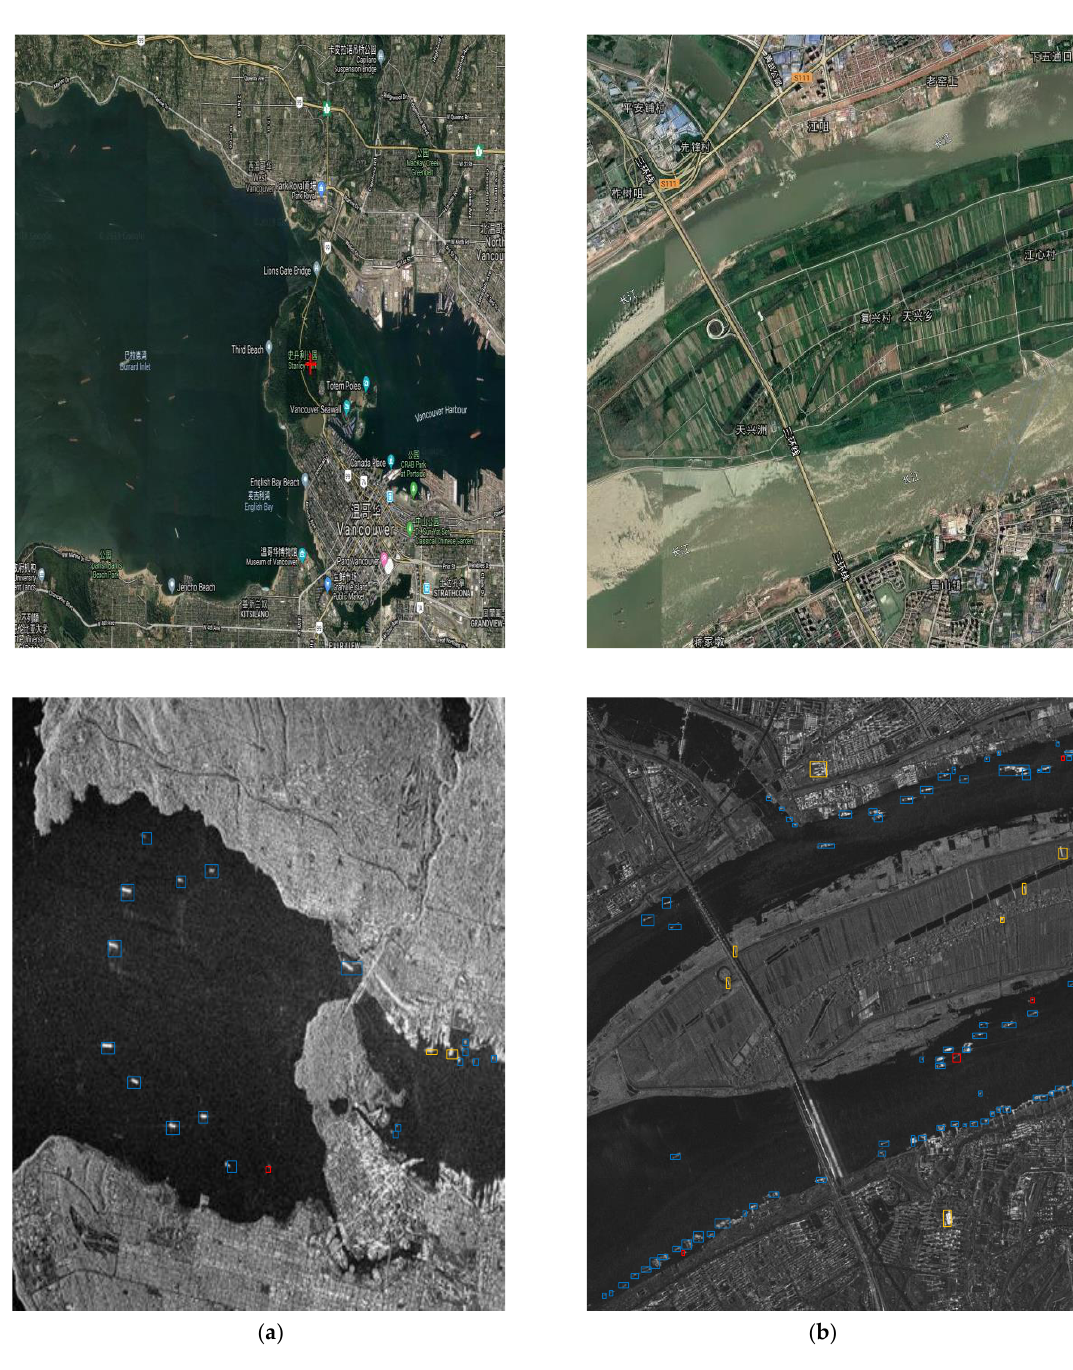
Figure 20. The ship detection results of RadarSat-1 and Gaofen-3. ( a ) Image 1; ( b ) Image 2. Correct ship detection is marked in blue, the miss-detection is marked in red, and the false alarm is marked in yellow.